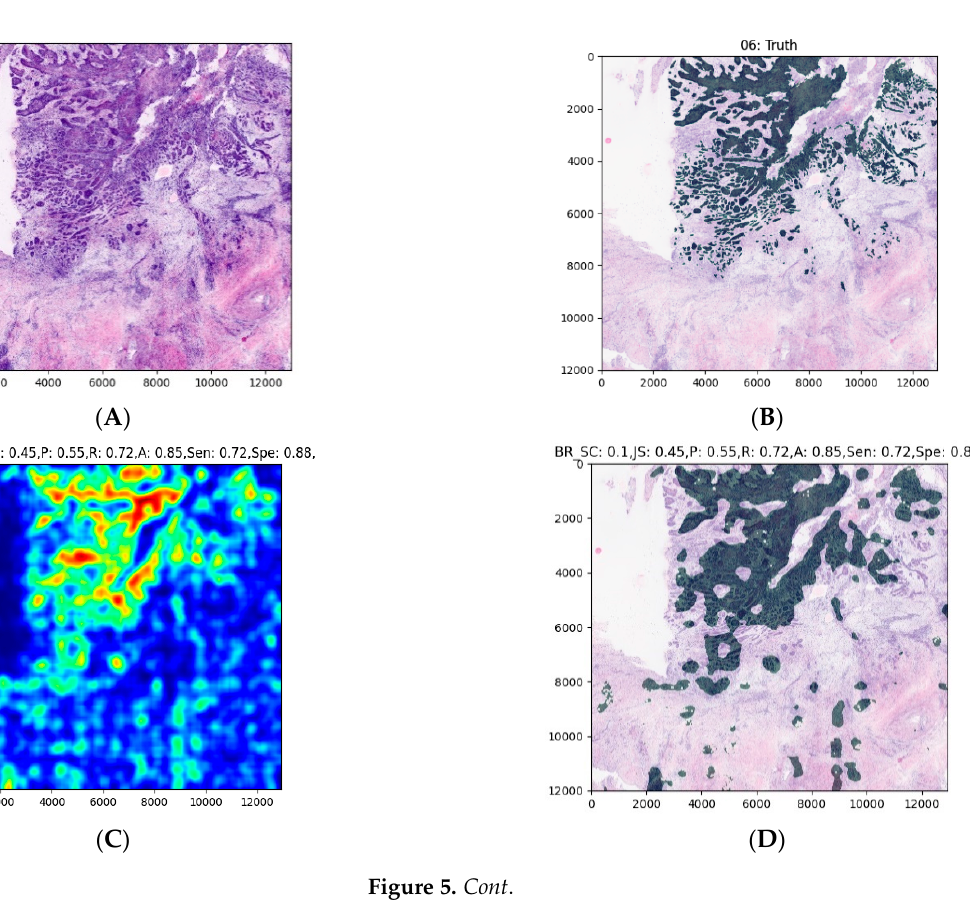
Figure 4. An example of an OSCC ex vivo FCM image with manually annotated cancerous regions and automated prediction. Image ( A ) is the input to the model, i.e., digitally stained ex vivo confocal microscopy scan, which was delivered in a sequential manner as explained in the Section Material and Methods. Image ( B ) contains the expert annotation high- lighted in green. Image ( C ) shows the predicted heatmap. The colormap used is called jet, and it ranges from blue to red, where the former represents the not SCC and the latter SCC. Image ( D ) presents the prediction mask generated from the heatmap, using the described approach in the Section Materials and Methods. Image ( E ) is a per-row normalized confusion matrix, the number 0 represents the class, not SCC, and 1 represents SCC. The abbreviations above the images ( C , D ) are the following: BR_SC for Brier score, JS for Jaccard score, P for precision R for recall, A for accuracy, Sen for sensitivity, and Spe for specificity. An entire heatmap and segmentation mask was compared with the experts’ annotations. As we can see in this example, the annotated area could be sufficiently predicted by the model.